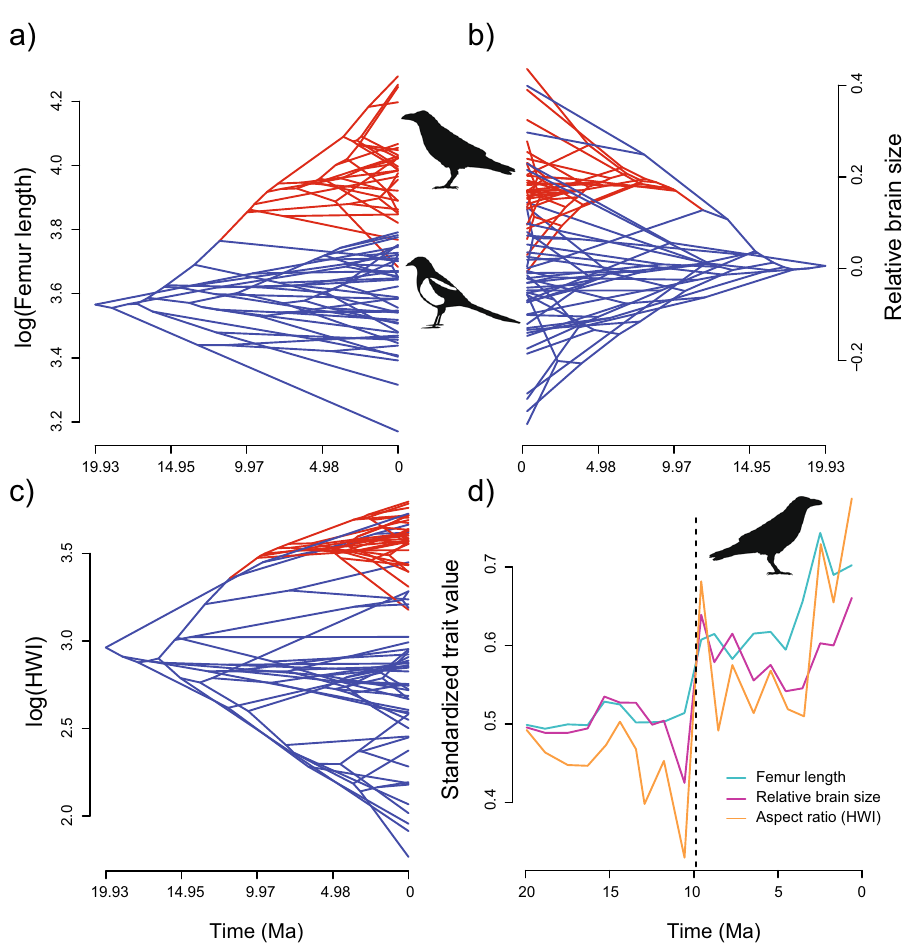
Fig. 6 Evolution of body size (as estimated from femur length), wing shape (as estimated by “ hand-wing index ” , HWI), and relative brain size in the family Corvidae. The vertical positions of nodes in phenograms a – c depict the reconstructed values of a given trait, whereas their horizontal position (i.e., time of divergence) and connectivity re fl ect the underlying phylogeny ( Corvus branches are highlighted in red). d Clade-wide patterns of variation in the mean ancestral body size, HWI, and relative brain size through